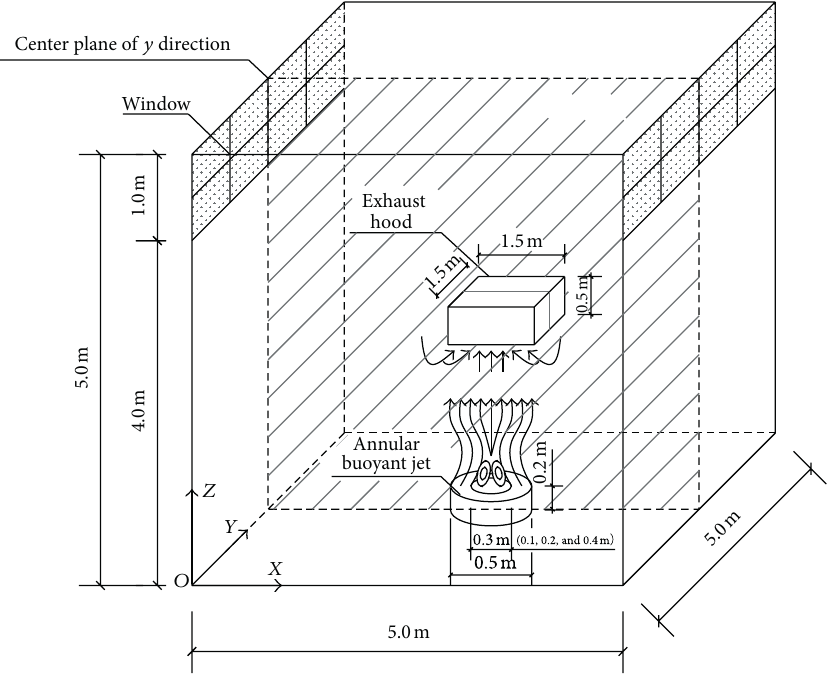
Figure 1: Configuration of the simulated